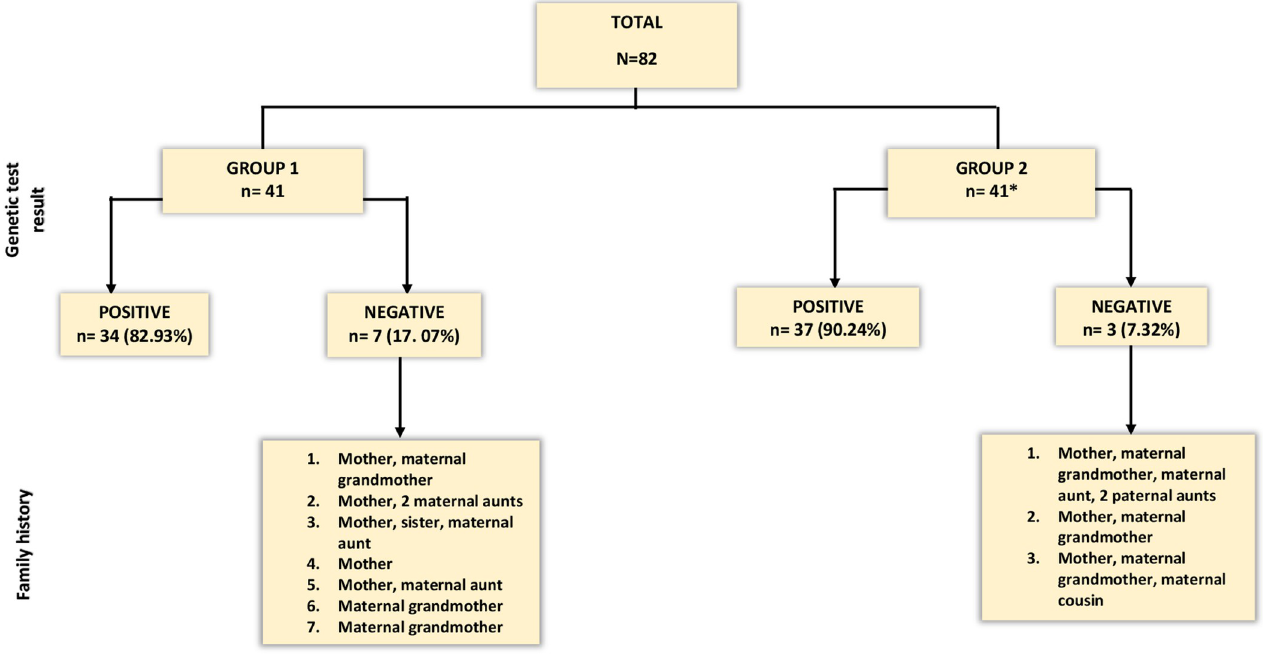
Fig 1. Genetic test outcome for all patients and family history breakdown for patients with negative genetic results. A positive family history was defined as at least one first or second degree relative with breast or ovarian cancer. * In Group 2, one patient was not genetically tested and did not have positive family history. However she was a candidate for prophylactic surgery due to a significant past medical history of Ewing’s sarcoma of the right lung, treated by radiotherapy, surgery and post-operative chemotherapy.